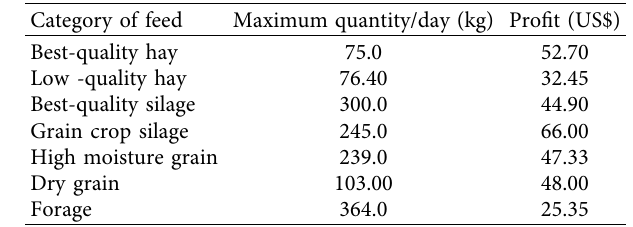
Table 6: Feed available options versus profit.